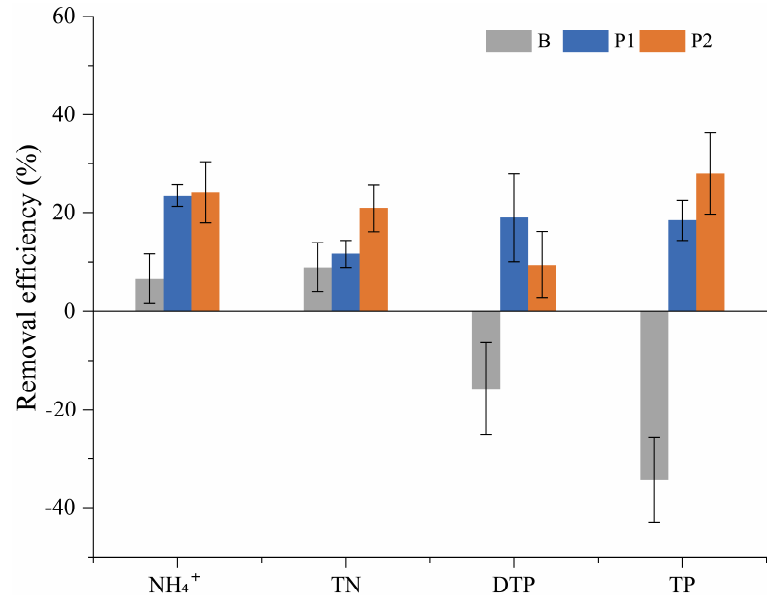
Figure 6. Average removal efficiency of ammonium (NH 4+ ), total nitrogen (TN), dissolved total phosphorus (DTP), and total phosphorus (TP) of three plots in 60 min.